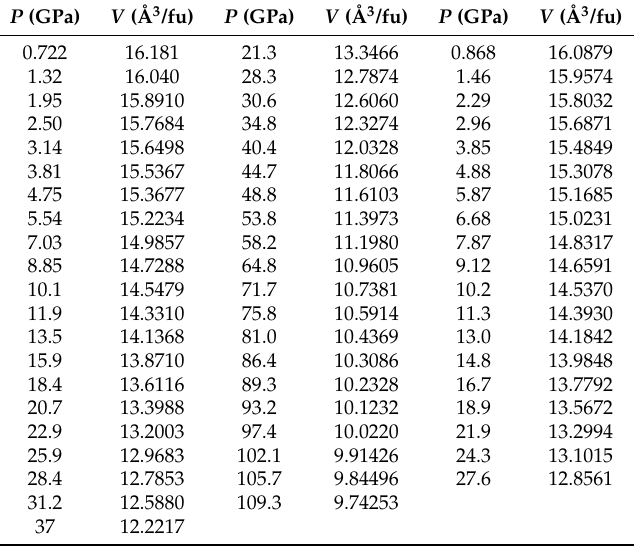
Figure 4. Volume of LiF measured in this study and in the literature [29,30]. Table 4. Pressure P (from ruby luminescence, with calibration from [4]) and volume V (measured with X-ray diffraction) for LiF. Each pair of columns corresponds to one experimental run. The data are listed in the order they have been